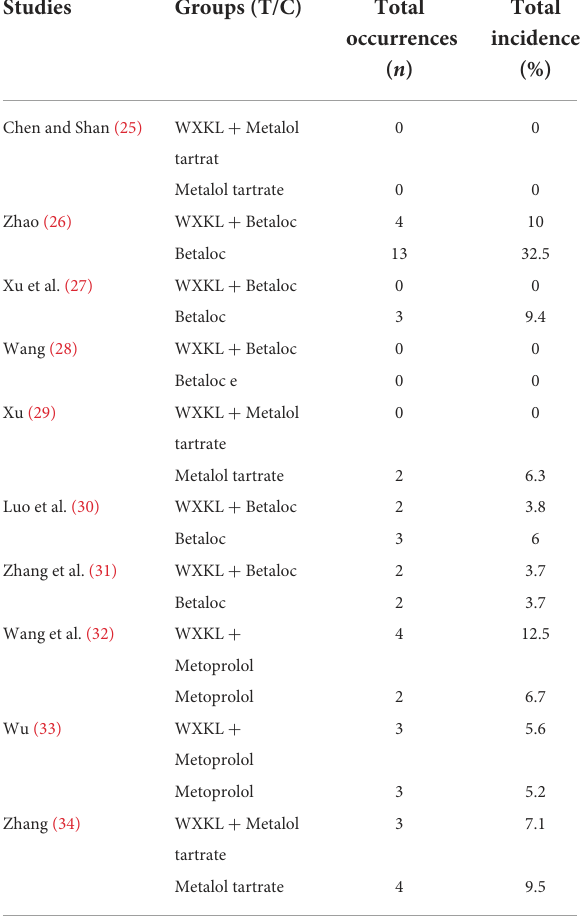
TABLE 5 The incidence of adverse